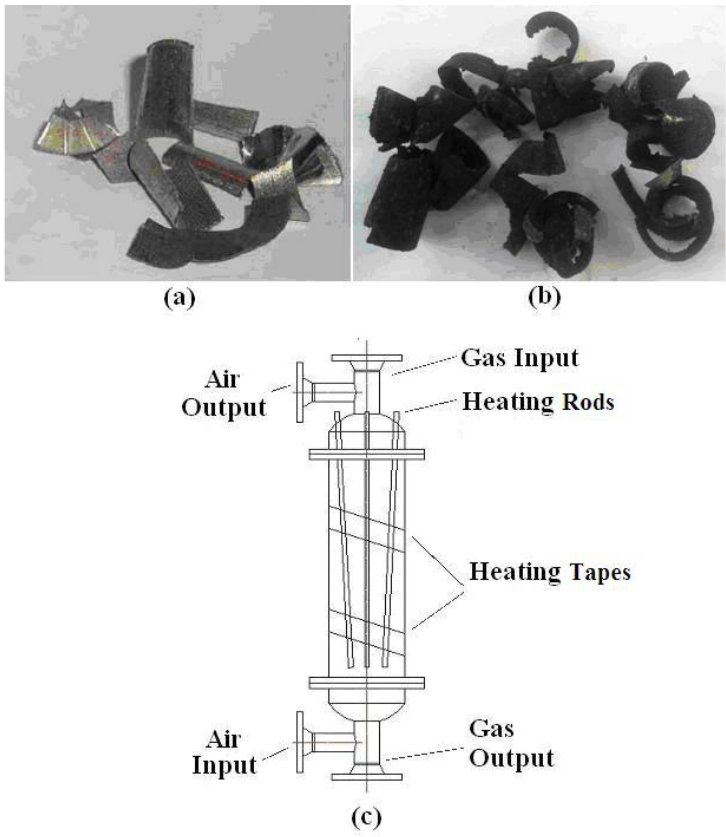
Figure 3. ( a ) Catalyst pieces; ( b ) Deactivated catalyst; and ( c ) Reactor for catalytic